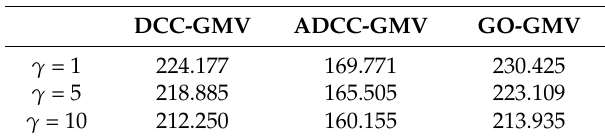
Table 9. Performance fees: Long only.